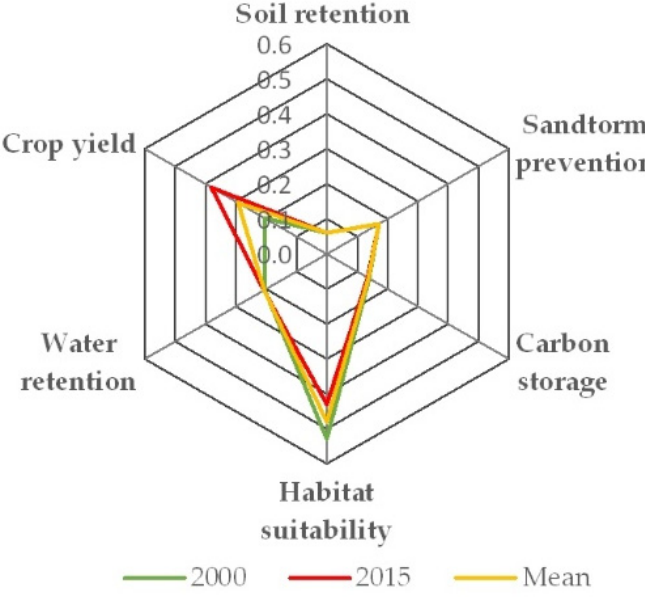
Figure 5. Radar maps of the standardized ESs.